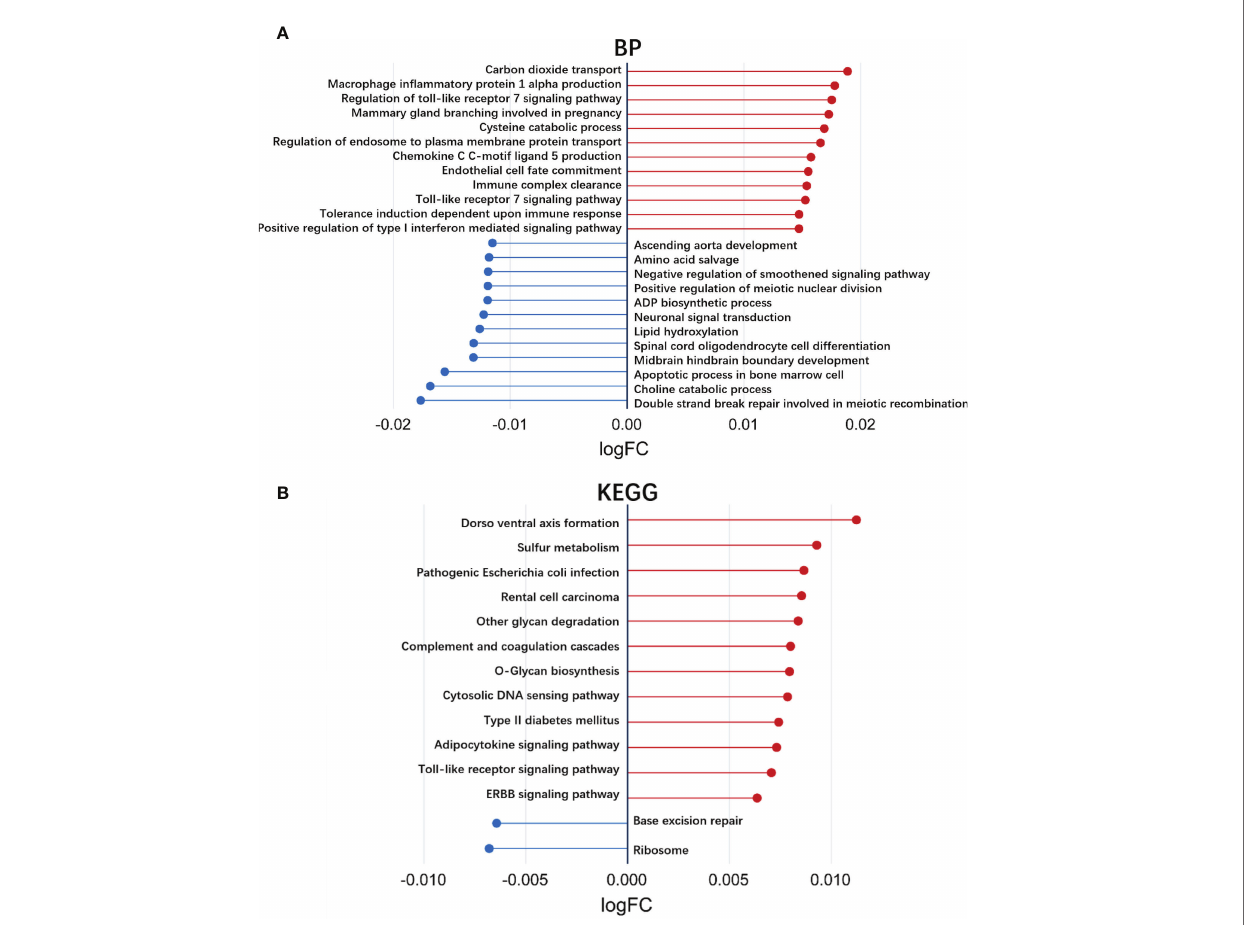
FIGURE 3 | Exploration of the different biological processes terms and KEGG pathways using gene set variation analysis (GSVA). (A) Up- or down-regulated biological processes between responders and non-responders in IFX treatment for RA in the GSE78068 dataset quanti fi ed by GSVA. (B) Up- or down-regulated KEGG pathways between responders and non-responders in IFX treatment for RA in the GSE78068 dataset quanti fi ed by